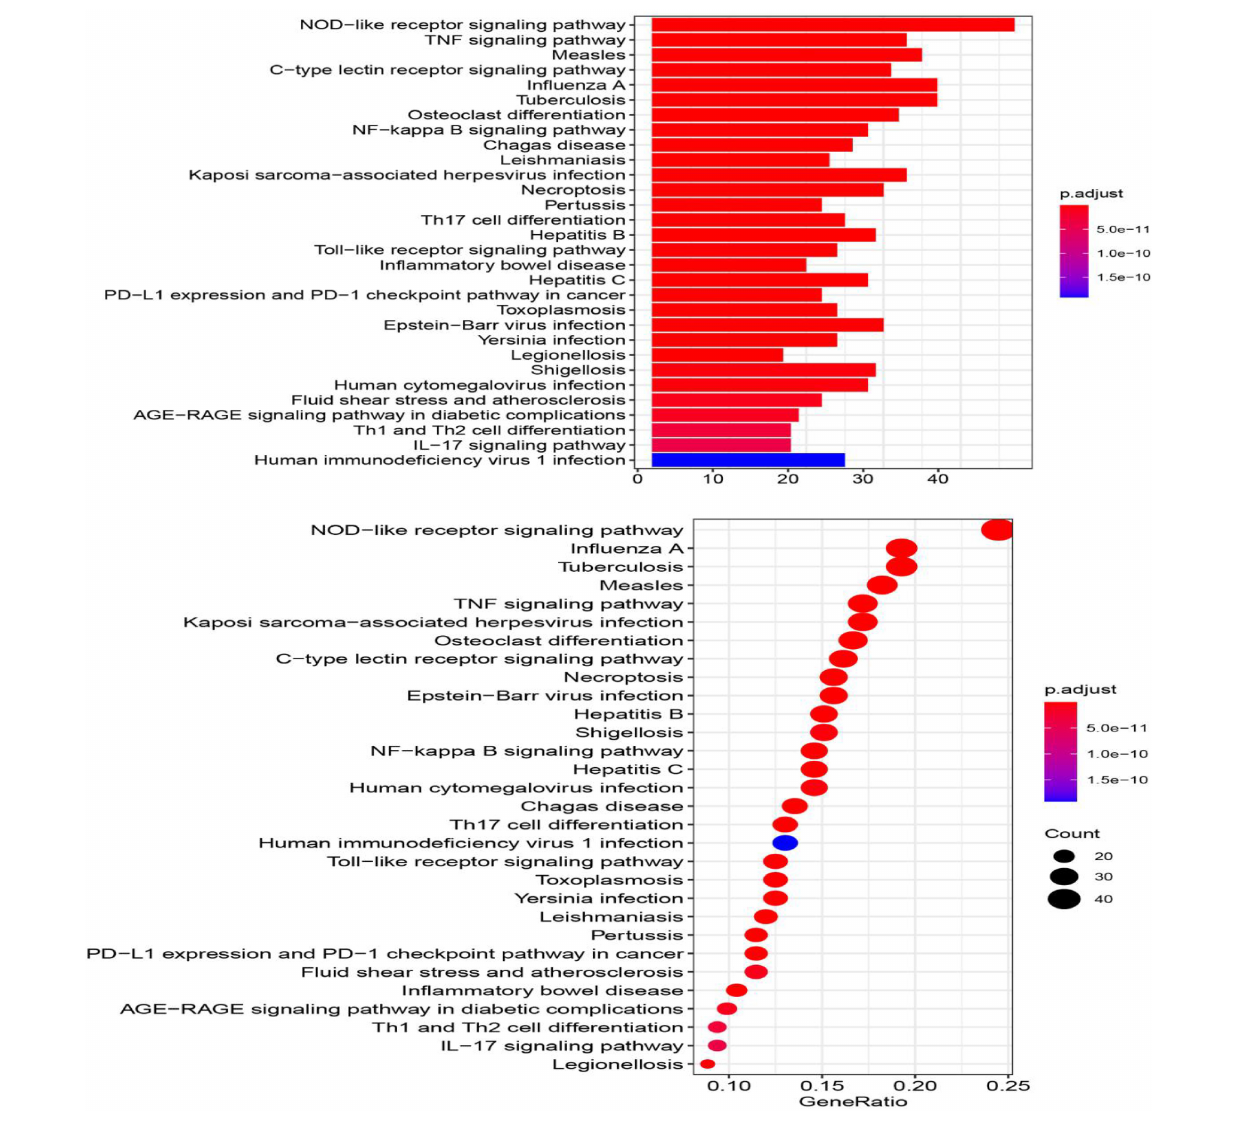
of stroke ( Figure 11A ). Expression levels of 10 key genes screened in the transcriptional regulatory network showed that the STAT3 gene and HIF1A gene showed similar transcriptional regulatory relationship in both the datasets, whereas TP53 as a transcription factor and its target gene JUN did not consistency in the expression pattern ( Figure 11B ) suggesting immune type heterogeneity in